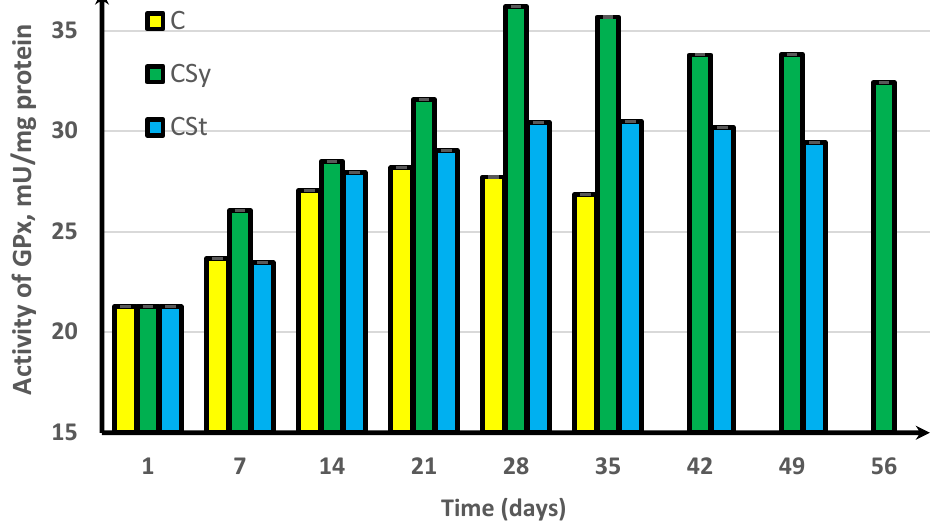
Figure 4. Peroxidase (GPx) activities in workers’ hemolymph along with the aging processes, after using two methods of supplementation with hemp extract. C, control (pure sugar syrup); CSy, hemp extract in syrup; CSt, hemp extract on strips (two-way ANOVA: supplementation method: F (5,1078 ) = 41,905, p = 0.0000, se ± 0.013879 (C), se ± 0.011332 (CSy), and se ± 0.012849 (CSt); days of supplementation: F (5,1078) = 41,905, p = 0.0000, se ± 0.019628 (1st–35th days), se ± 0.033996 (42nd day and 56th day), se ± 0.024039 (49th day); supplementation method × days of supplementation F (11,1078) = 2910.4, p = 0.0000, and se ± 0.033996). The chart shows statistical averages. The standard deviations for the means in this plot ranged from 0.06757 to